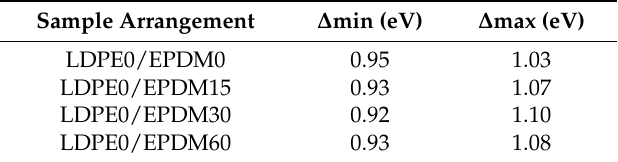
Figure 8. Interface charge dissipation for different sample arrangements. Table 1. Relationship between apparent interface trap depth and surface fluorination treatment.